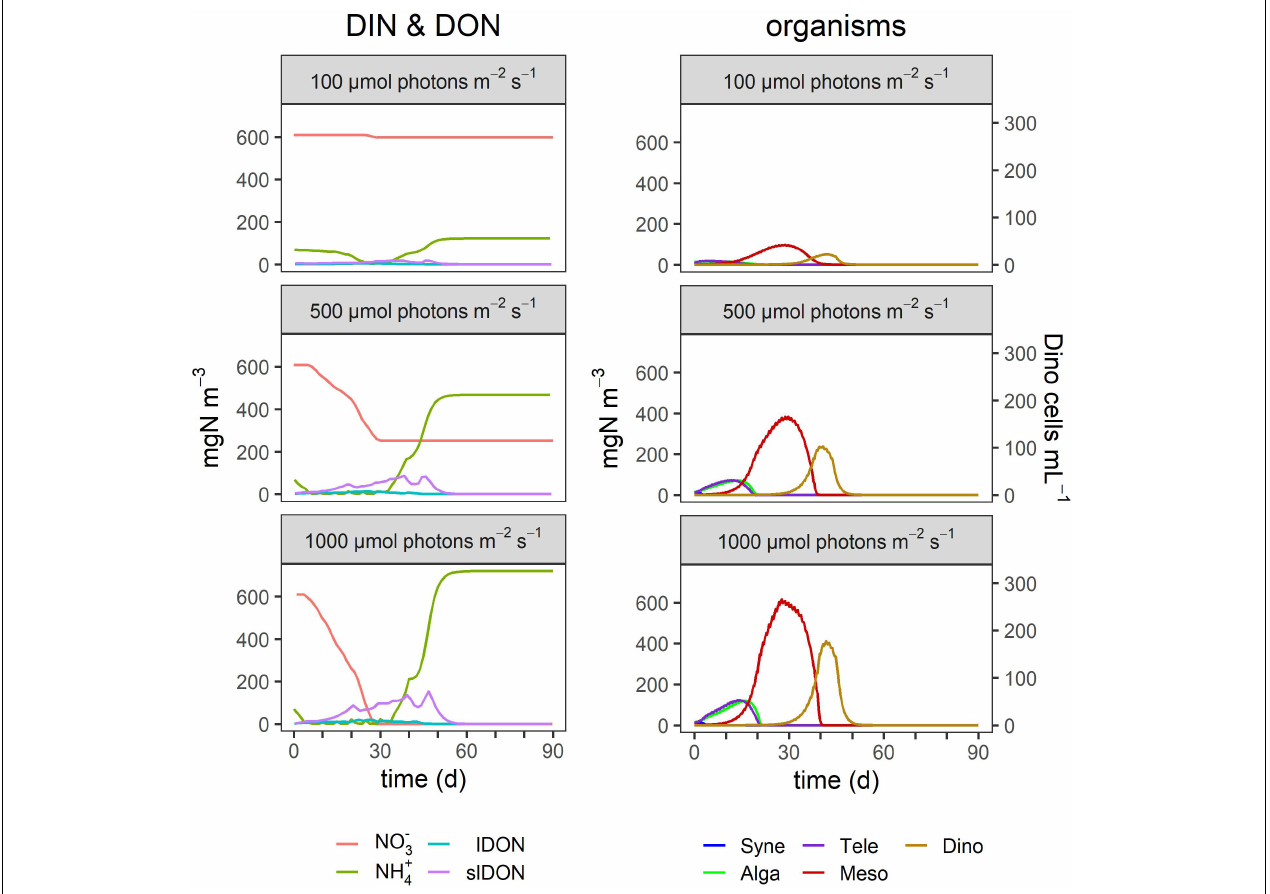
FIGURE 6 | Effect of surface irradiance on TMD dynamics. The outputs for 500 µ mol photons m − 2 s − 1 replicate the conditions used for Figure 4 . Other details as given in Table 4 and in the legend of Figure 4